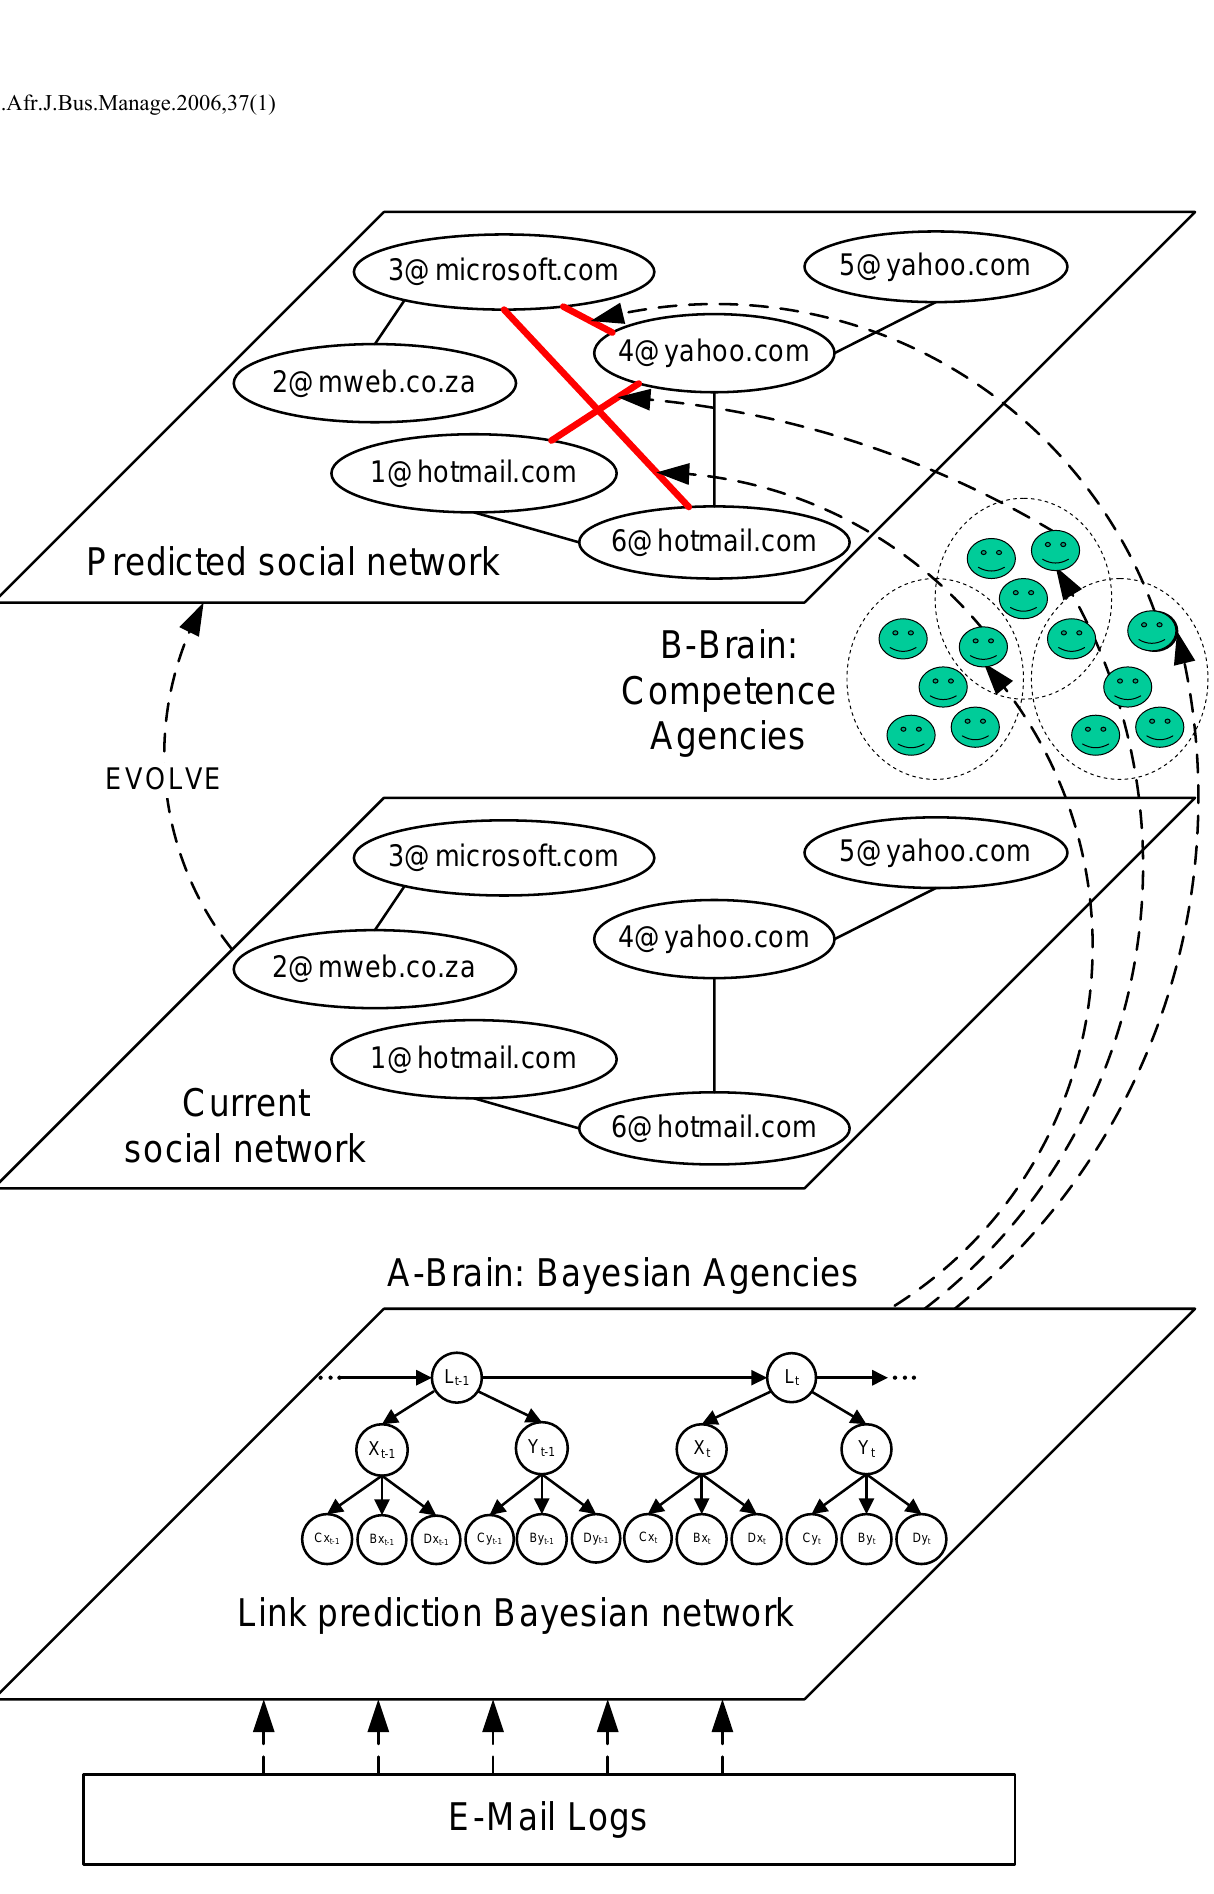
Figure 3: Proposed Link Prediction